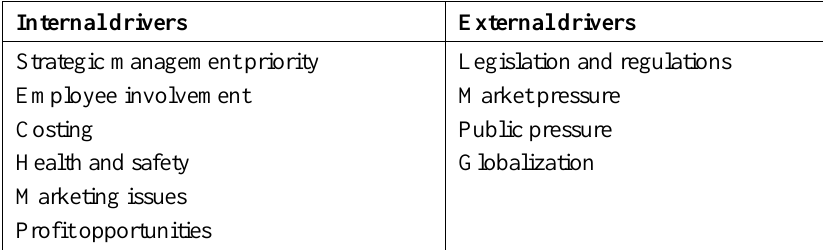
Table 3. Motivations for the incorporation of sustainability considerations (Tsoulfas & Pappis, 2012, p.